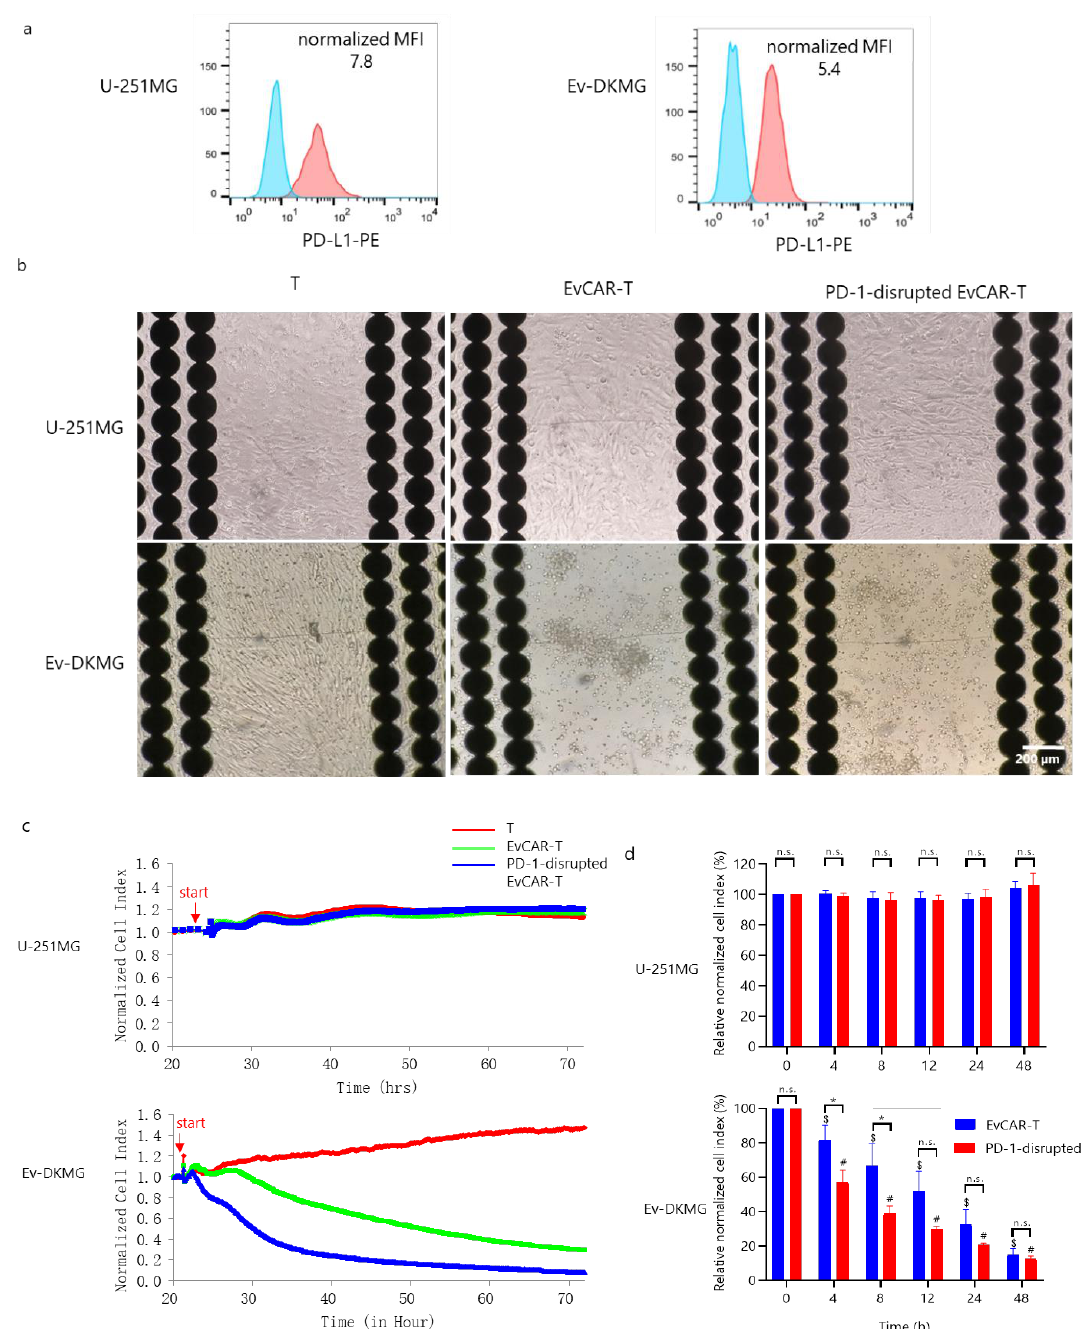
Figure 4. Enhanced growth inhibition of human glioblastoma (GBM) cells by CRISPR/Cas9-mediated PD-1 disruption in EvCAR-T cells. ( a ) PD-L1 expression in U-251MG and EGFRvIII-expressing DKMG cells. The upper and lower panels depict U-251MG and EGFRvIII-expressing DK-MG GBM cells, respectively. The blue and red curves represent the isotype control and anti-PD-L1 antibody, respectively. ( b ) Images of GBM cell lines co-cultured with T cells, EvCAR-T cells, and PD-1-disrupted EvCAR-T cells (left, middle, and right, respectively) at 72 h after culture. The upper panels and lower panels depict U-251MG and EGFRvIII-expressing DKMG cells, respectively. ( c ) Representative graphs of the RTCA-based growth inhibition assay. U-251MG (upper graph) and EGFRvIII-expressing DKMG (Ev-DKMG, lower graph) cells were co-cultured with T cells (red line), EvCAR-T cells (green line), or PD-1-disrupted EvCAR-T cells (blue line). The X and Y axis represent the co-